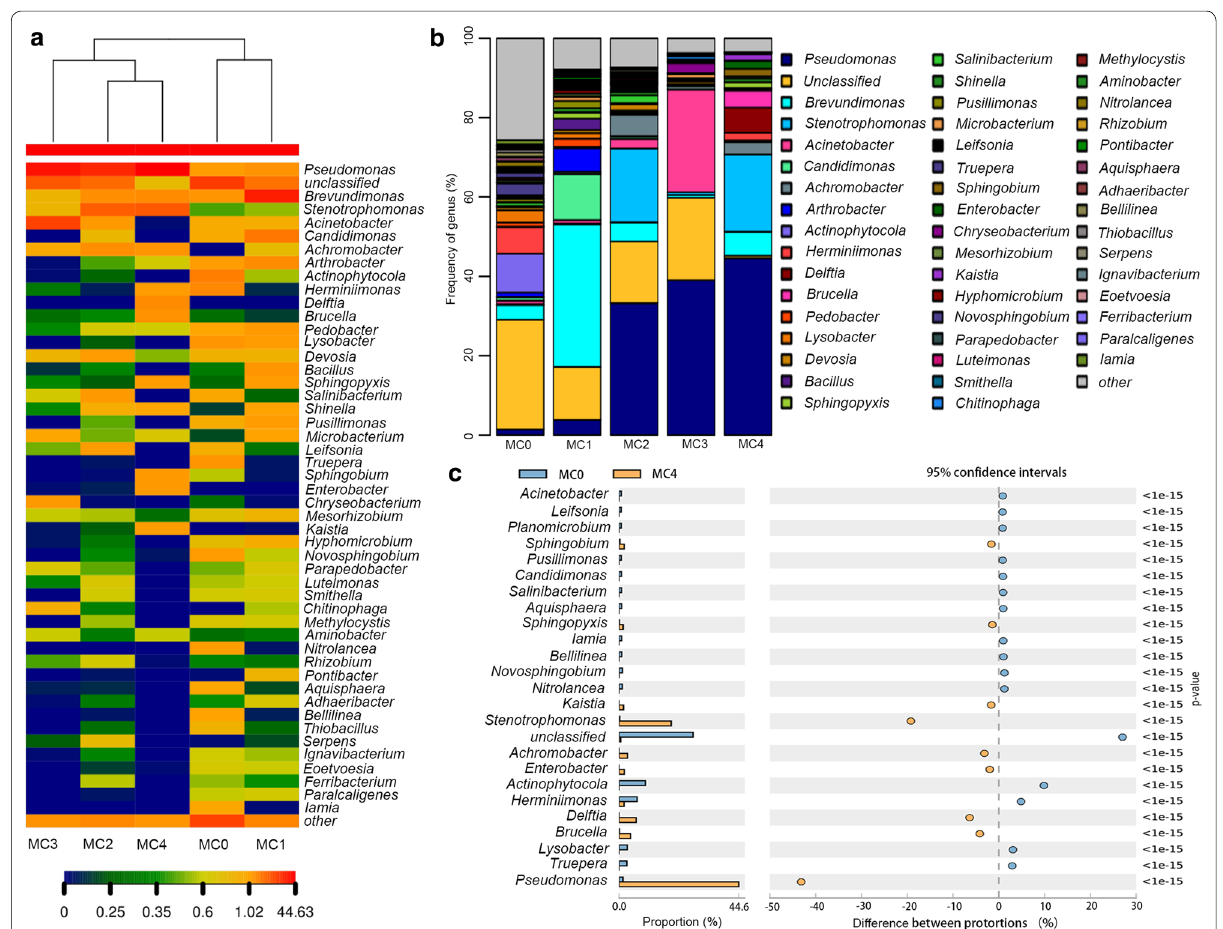
Fig. 1 Dynamic composition changes of microbial communities, heatmap of genus ( a ), microbial communities composition changes ( b ), genus difference between MC0 and MC4 ( c